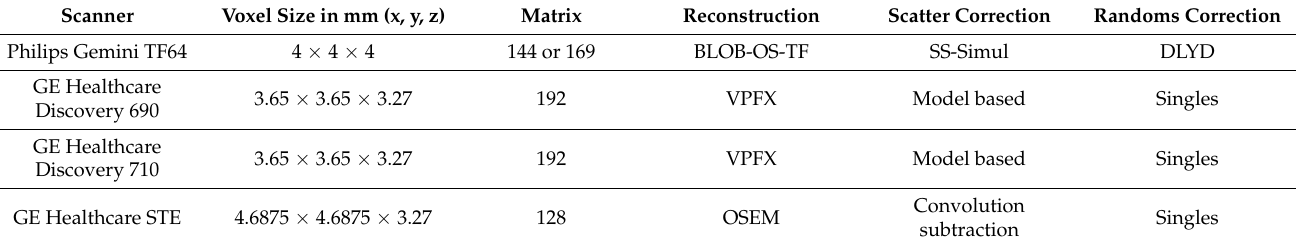
Table 1. Reconstruction parameters for the different scanners